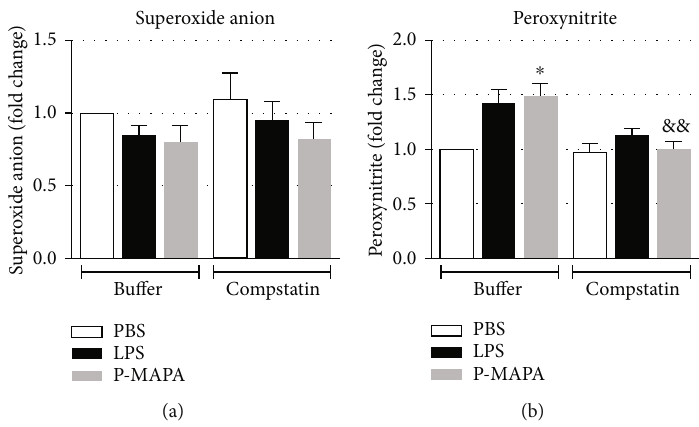
Figure 6: Production of oxygen and nitrogen of reactive species production after complement inhibition and P-MAPA stimulation. Blood samples were preincubated with compstatin (1 mM) (10 min, RT) or left untreated, ahead of stimulation with PBS, LPS (100 μ g/ml), or P-MAPA (1000 μ g/ml) for 1 h with DHE at 37 ° C for the detection of superoxide (a) or with DHR at 30 ° C for detection of peroxynitrite (b), in 5% CO incubator. Erythrocytes were lysed and samples analysed by fl ow cytometry. Data are the mean of three 2 separate experiments, from three independent donors, performed in duplicate, and results are expressed as the fold change of median fl uorescence intensity (MFI) compared to the control group ± SEM. Comparison between compstatin-treated and compstatin-untreated samples were analysed using the Mann-Whitney test. ∗ p < 0 : 05 : signi fi cant di ff erences between the mean values with PBS control. && p < 0 : 01 : signi fi cant di ff erences between compstatin-treated and compstatin-untreated